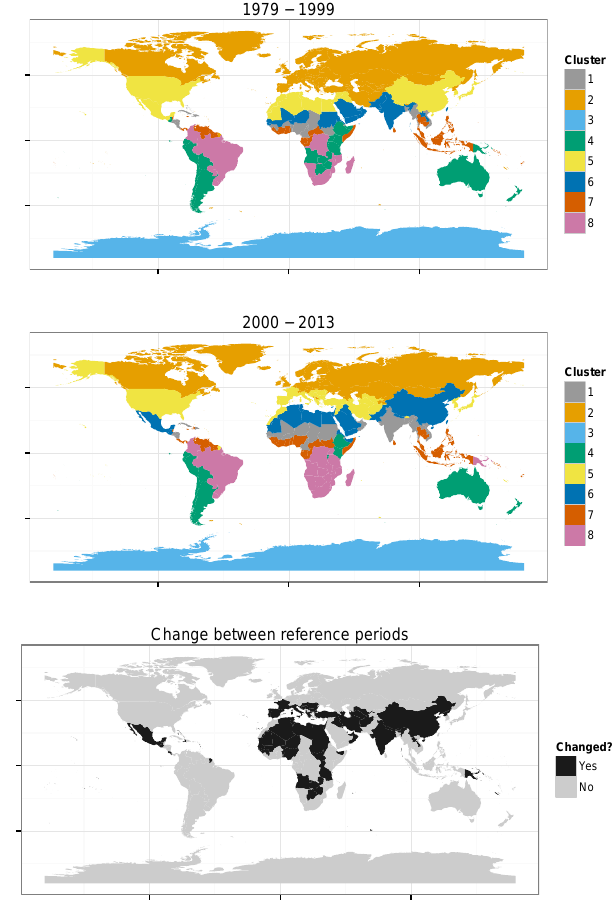
Figure 5. Countries and the clusters they were grouped into. The map at the top shows country clusters for the first reference period, and the map in the middle shows county clusters for the second. The map at the bottom indicates whether the cluster that a country was grouped into changed between both